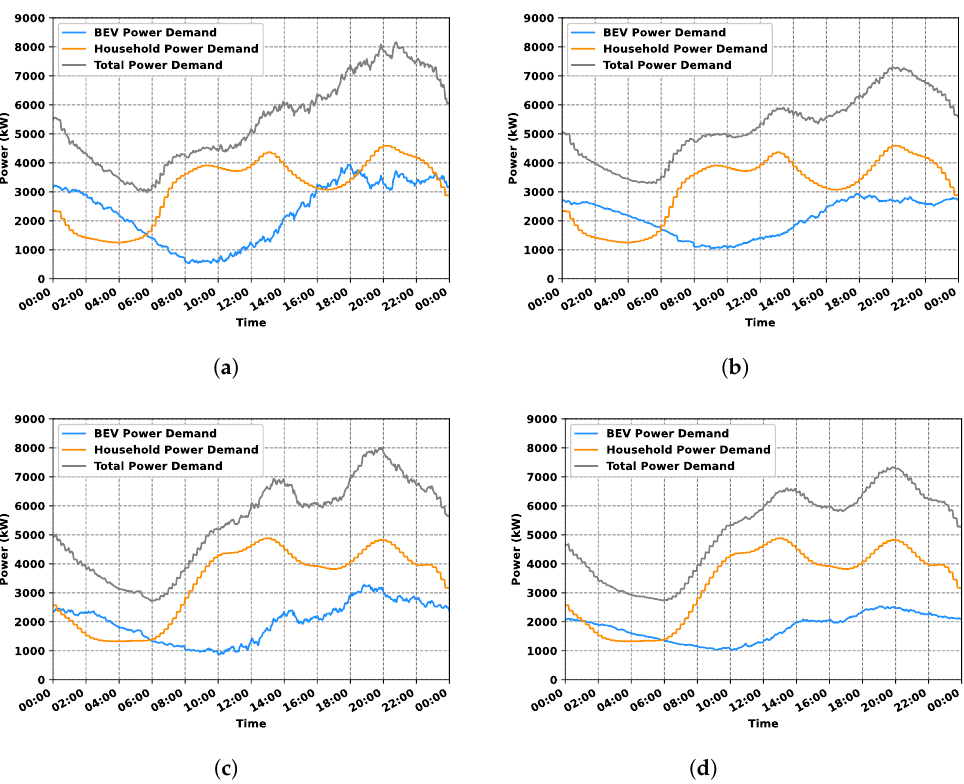
Figure 13. Temporal distribution of the BEV charging power demand for the LOR “Heiligensee”. ( a ) Working day (Monday–Thursday), 11 kW, ( b ) Working day (Monday–Thursday), 3.7 kW, ( c ) Saturday, 11 kW, ( d ) Saturday, 3.7